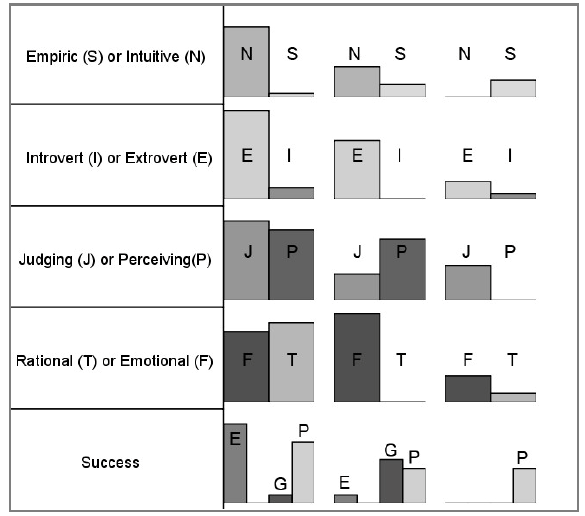
Fig. 6. Student profiles for course on English language These students should work on developing a “sense” for language by more involving in listening conversations between native speakers or reading and understanding